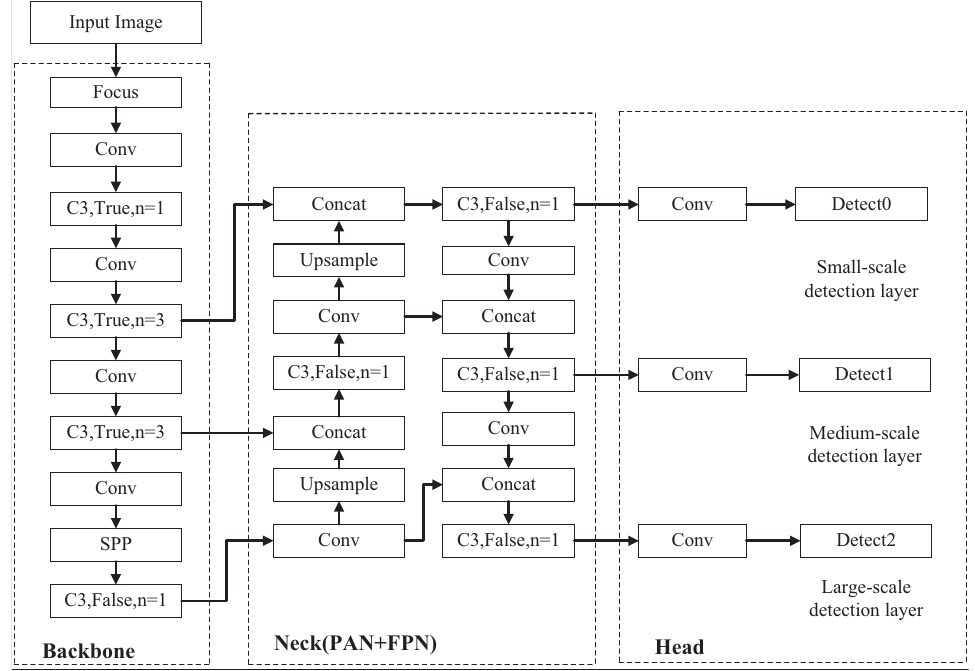
Figure 2. Overall network structure of the YOLOv5s model. The backbone network convolves the input image and converts it into feature maps of different sizes. The neck network fuses high-level and low-level feature maps, and the fused feature maps are input into the detect network to detect objects in the